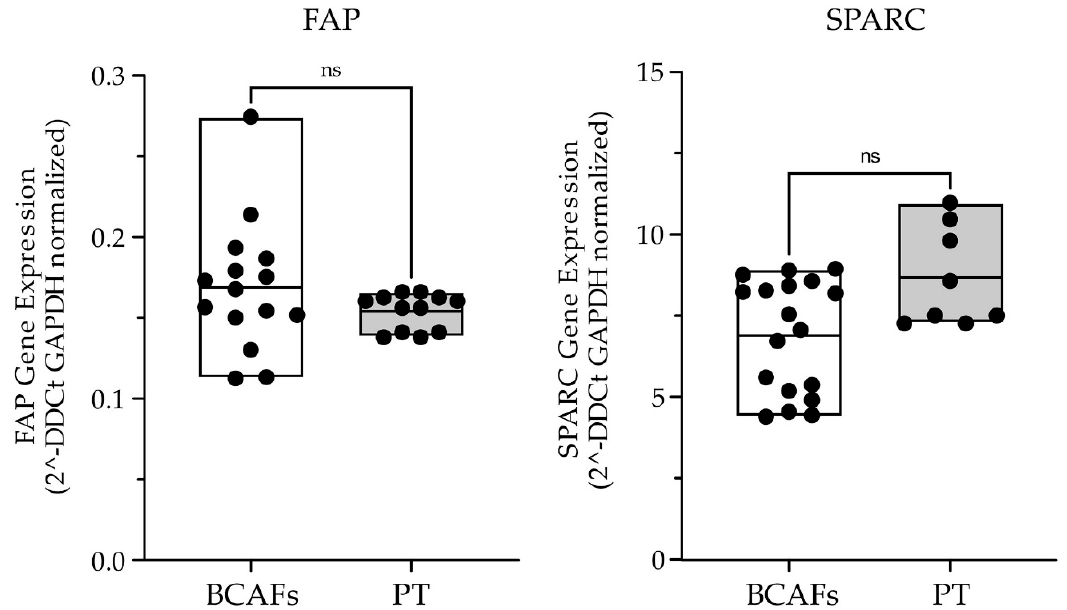
Figure 3. Real-Time Expression analysis of the CAF markers FAP and SPARC in human primary BCAFs (N = 3) and BC patient tissues (PT) (N = 3). Data are shown as percentage of mean +/ − SD from triplicates of three independent experiments. Statistical analyses were conducted by one-way ANOVA with Tukey’s post hoc analysis. ns: not significant.